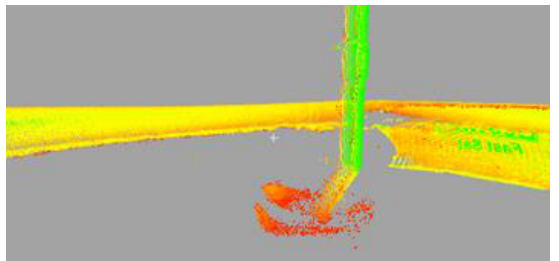
Figure 20. Three-dimensional laser scan before refraction correction for Trial 6 [36] (used with permission).